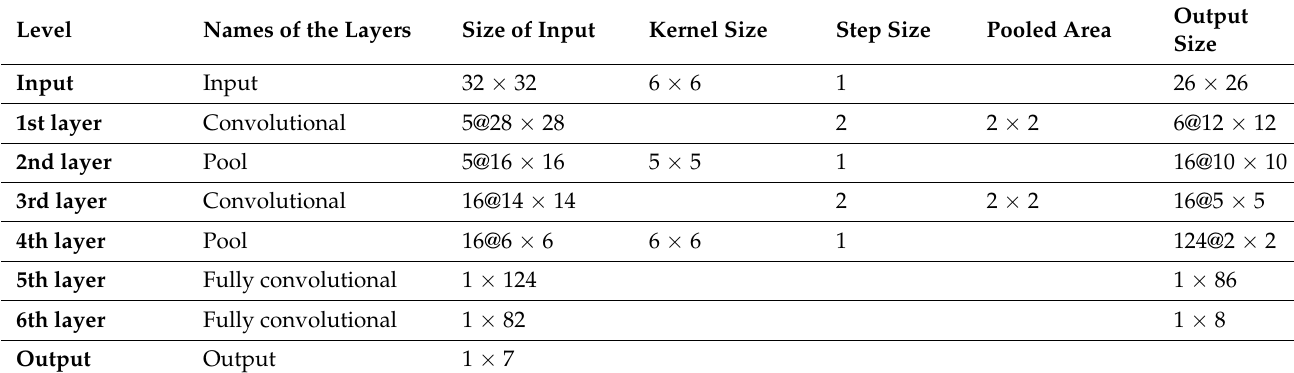
Table 2. Architecture of LeNet